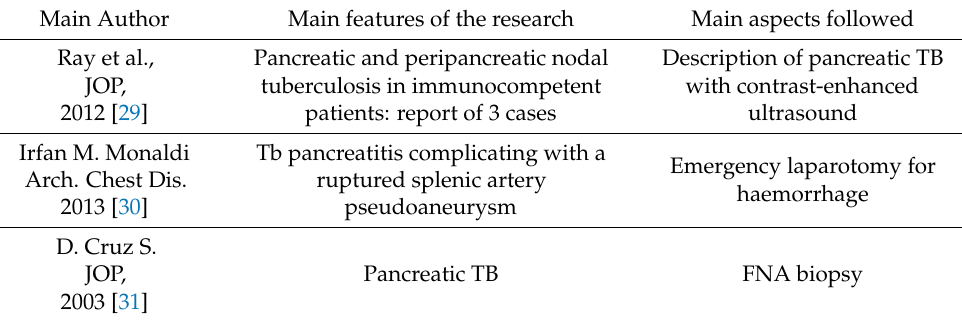
Table 6. Pancreatic